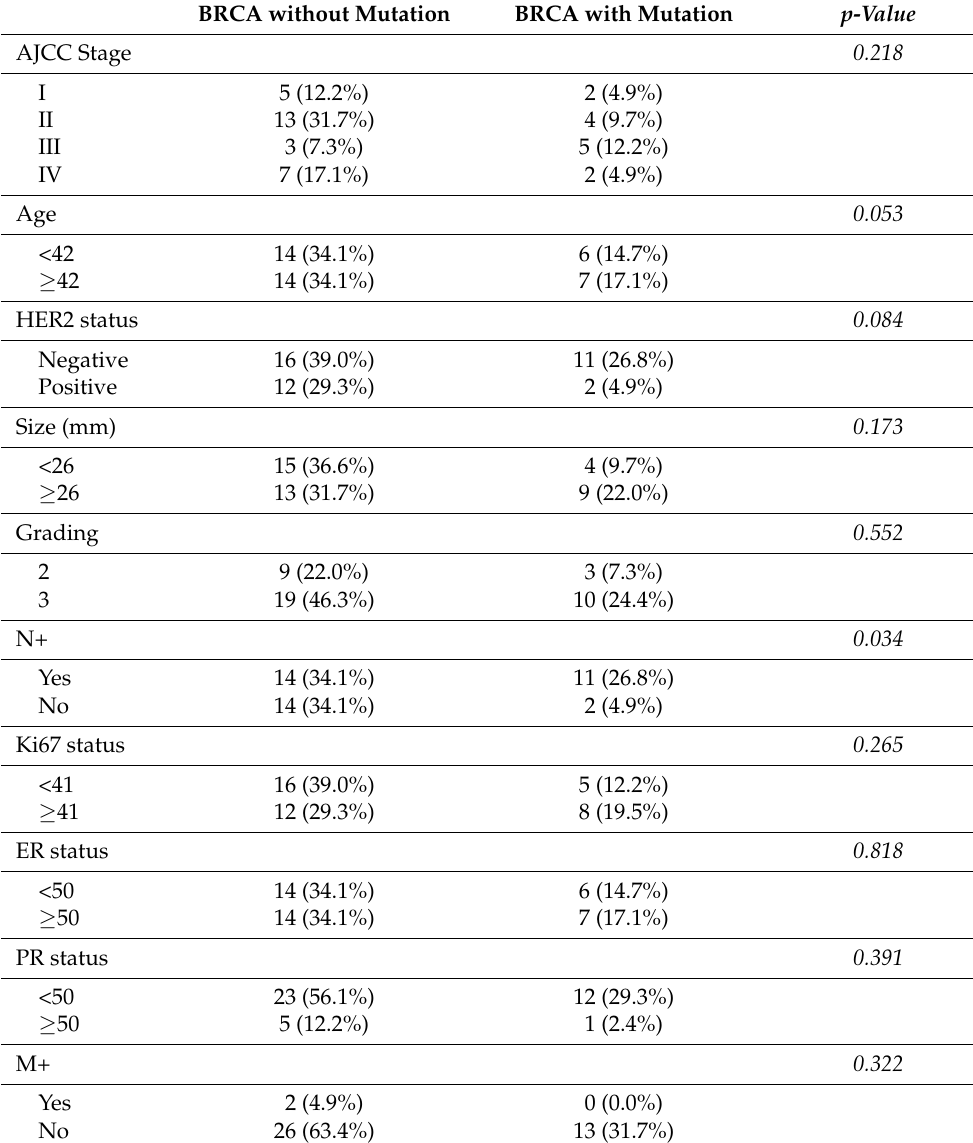
Table 3. Correlation between clinicopathological parameters and BRCA status. BRCA without Mutation BRCA with Mutation p -